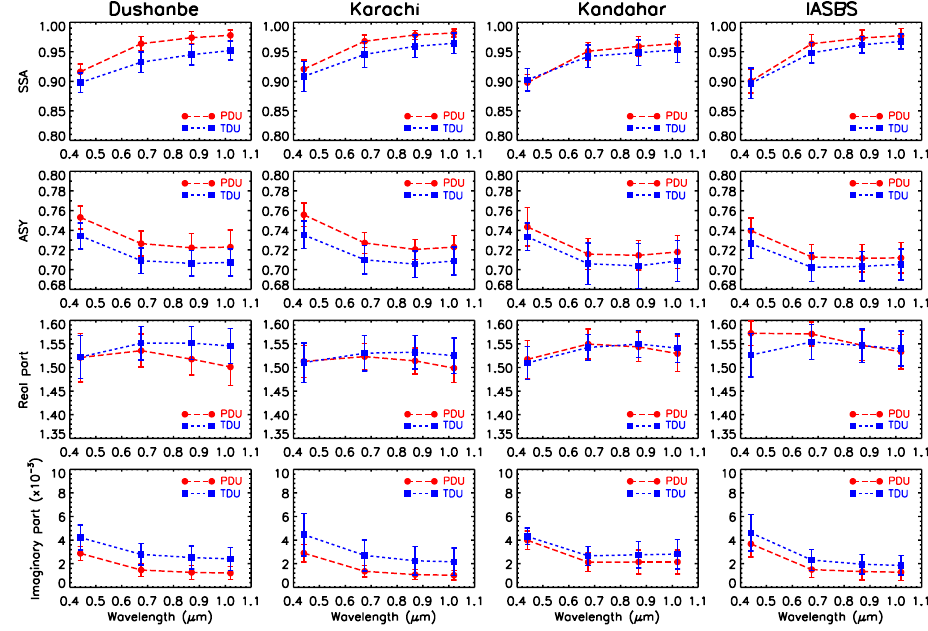
Figure 4. The same as Fig. 3, but for four selected Central Asian sites (Dushanbe, Karachi, Kandahar, and